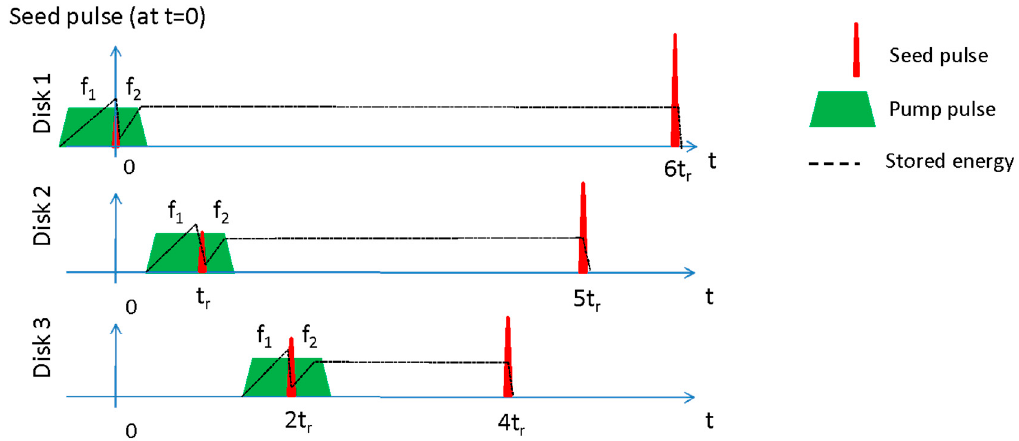
Figure 5. Overview of the synchronization scheme for the implementation of the EDP (Extraction During Pumping) strategy. Red peaks represent the amplified pulses, the green trapezoids represent the arrival of the pump pulses (including recycling), and the dashed line is the stored energy. The time t r is the transit time from one disk to the next one (about 24 ns for AMP3). The fraction of stored energy f 1 available for the amplification in the first transit can be adjusted by finely tuning the delay between the arrival of the amplified pulse and the pump pulse on each disk, leaving the remaining fraction f 2 available for the amplification of the second transit.